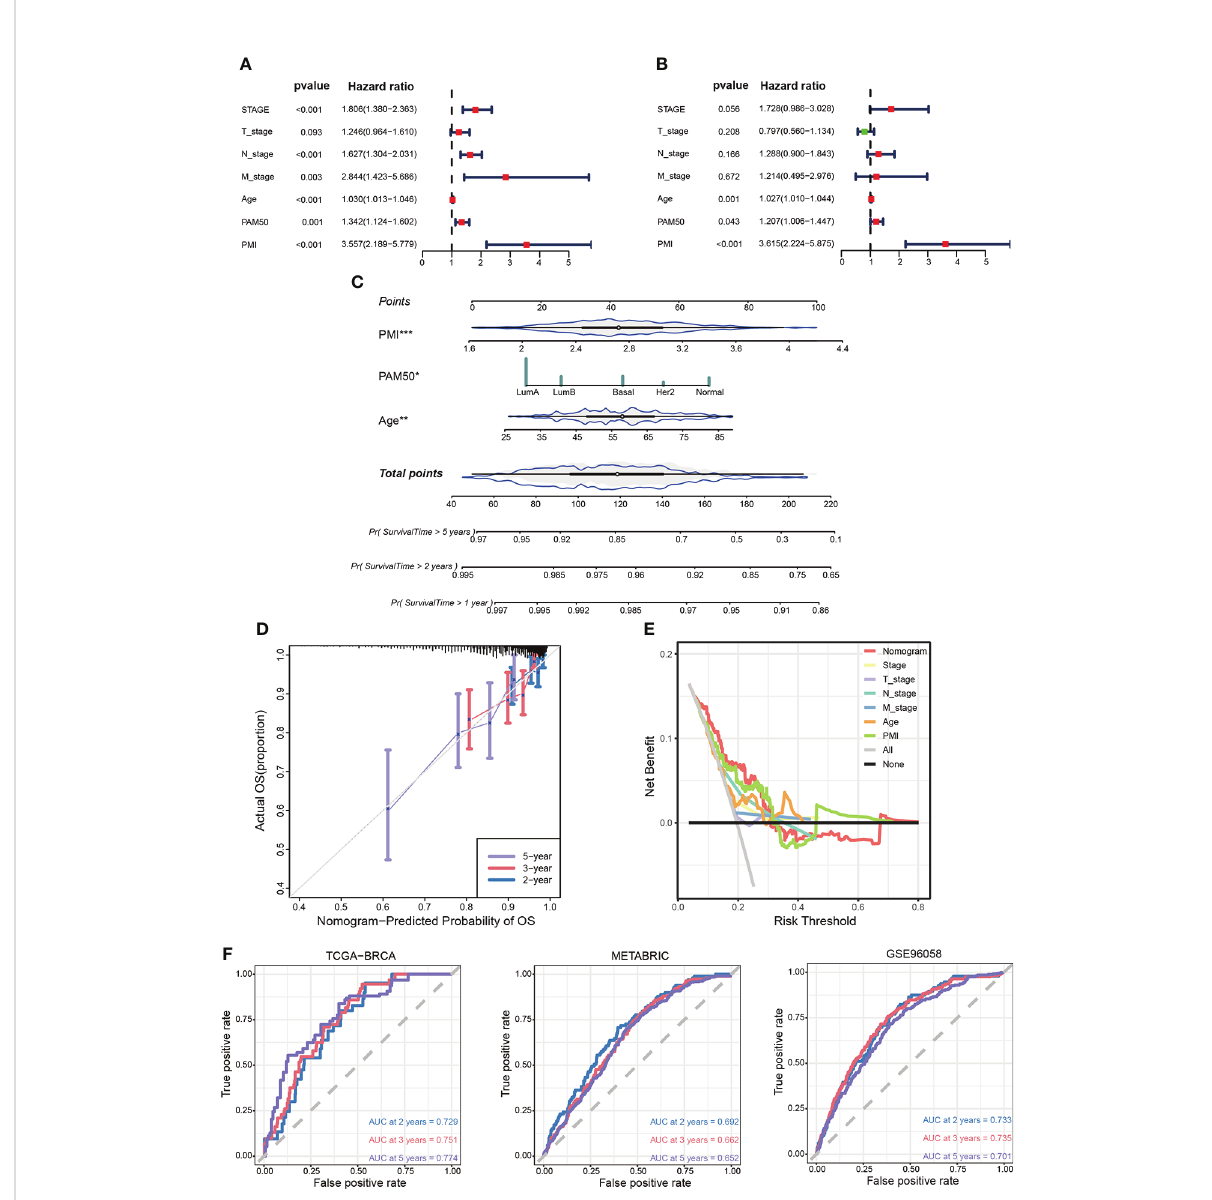
FIGURE 8 Establishment of a prognosis-related nomogram model based on PMI. (A) Univariate Cox regression analysis of PMI and clinicopathological characteristic. (B) Multivariate Cox regression analysis of PMI and clinicopathological characteristic. (C) Construction of a nomogram to predict OS of BC patients from TCGA-BRCA. (D) The calibration curve to estimate prediction accuracy of the nomogram based on the agreement of predicted OS with actual OS. (E) The decision curve to evaluate the clinical decision effectiveness of the nomogram against other separate clinical parameters. (F) The ROC curves and AUC values demonstrated favorable competence of the nomogram in predicting 2-, 3-, and 5-year OS of BC patients. *p < 0.05; **p < 0.01; ***p <